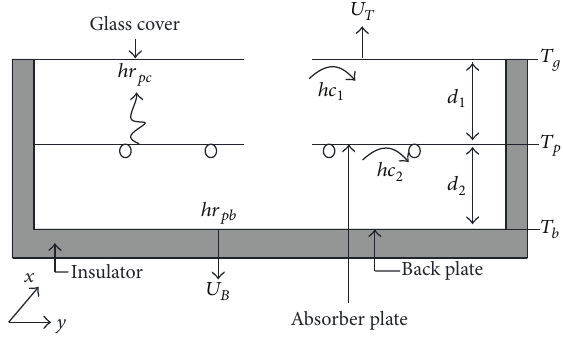
Figure 4: Heat transfer of components of the collector.